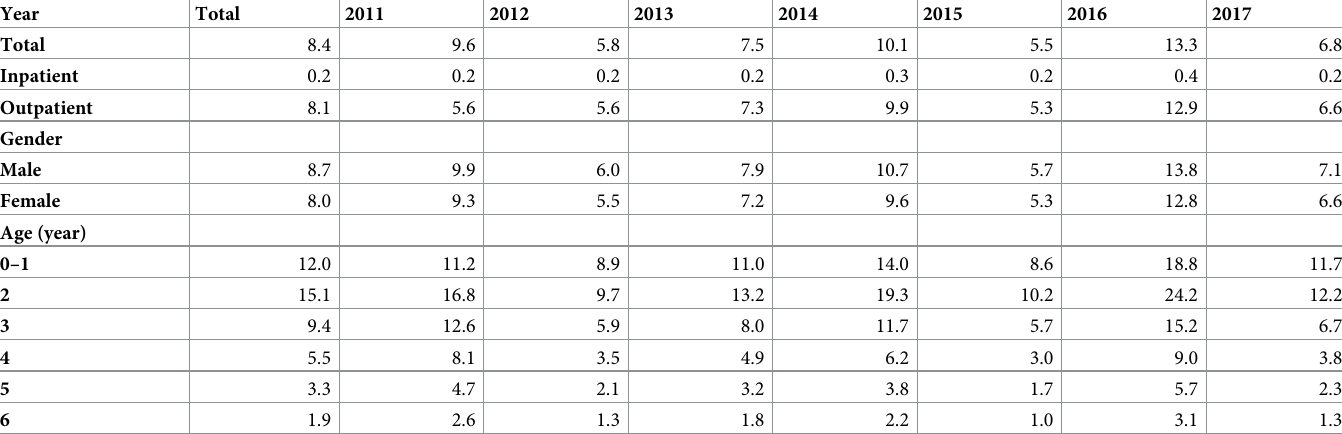
HFMD in Korea shows a seasonal pattern, with cases increasing in May and peaking in June (Fig 2). Spatial and temporal analyses were performed to explore the timing and location of HFMD epidemics by year. The location of the primary clusters (dark blue) varied, and 3–4 clusters were identified each year. The epidemic typically started between weeks 17–24 (May-June) and lasted until week 29 (July) or 39 (September). In 2014 and 2016, when the HFMD cumula- tive incidence was higher than 10 per 100 persons, the most likely spatio-temporal cluster area was located in southeast Korea, and the epidemic occurred during the 17th week of 2014 and the 21st week of 2016. The coverage area was larger clustering in more than a 100 km radius and the risk was higher (RR 4.21 in 2014, RR 6.34 in 2016). Whereas in 2015, when the HFMD cumulative incidence was relatively low, the most likely spatio-temporal cluster (RR 2.32) was mainly located in south-central Korea, an area covering 65 counties, and clustered between the 17th to the 38th week of 2015. (Fig 2). In 2011, the most likely cluster covered 34 administra- tive districts, including parts of Seoul and northern Gyeonggi between weeks 22 and 30 (June–